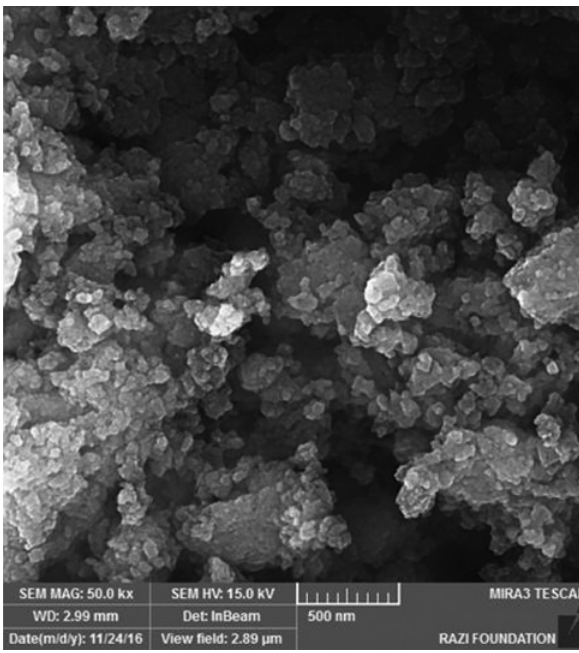
Figure 4: TGA of nano-colloidal silica @APTPOSS.